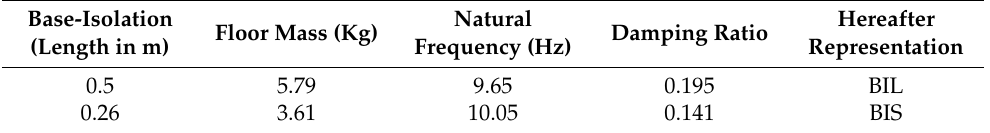
Figure 2. Base-isolation models. Table 2. Properties of base-isolation